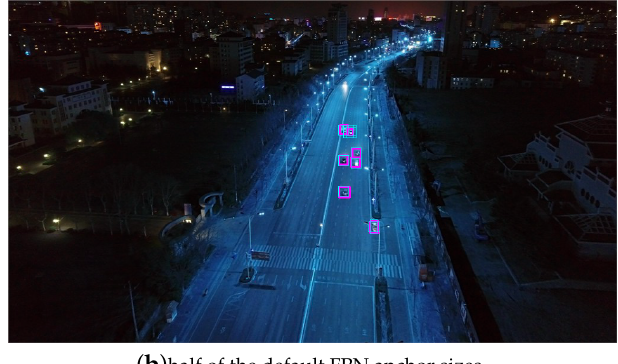
Figure 2. Sampling Results Example on Small